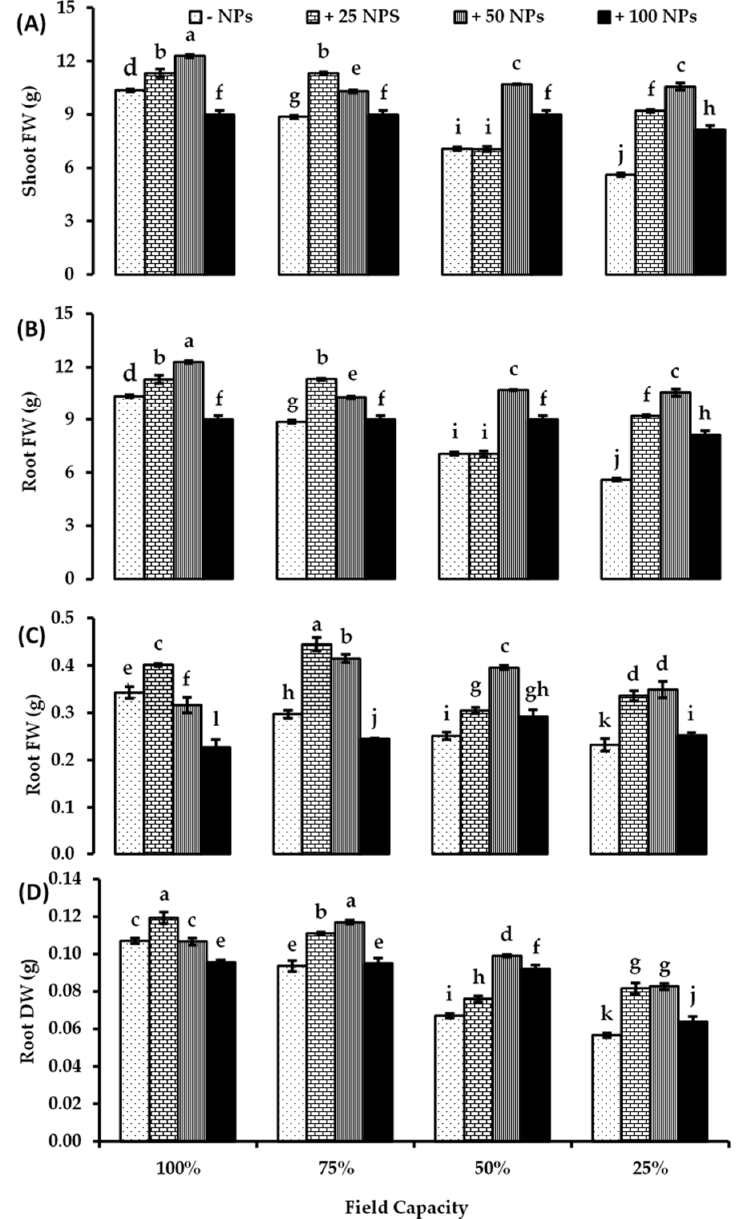
Figure 1. Biomass, ( A ) shoot fresh weight (FW), ( B ) shoot dry weight (DW), ( C ) root fresh weight, and ( D ) root dry weight of tomato plant as affected by foliar spraying with different concentrations of ZnO-NPs under different levels of drought stress. Each point represents a mean value of three replicates ( n = 3) with vertical bars representing standard error of the mean. Bars with different letters indicate a significant difference ( p < 0.05) between Zn-O NPs treatments at all studied water levels as determined by two-way ANOVA and Bonferroni multiple comparison test.